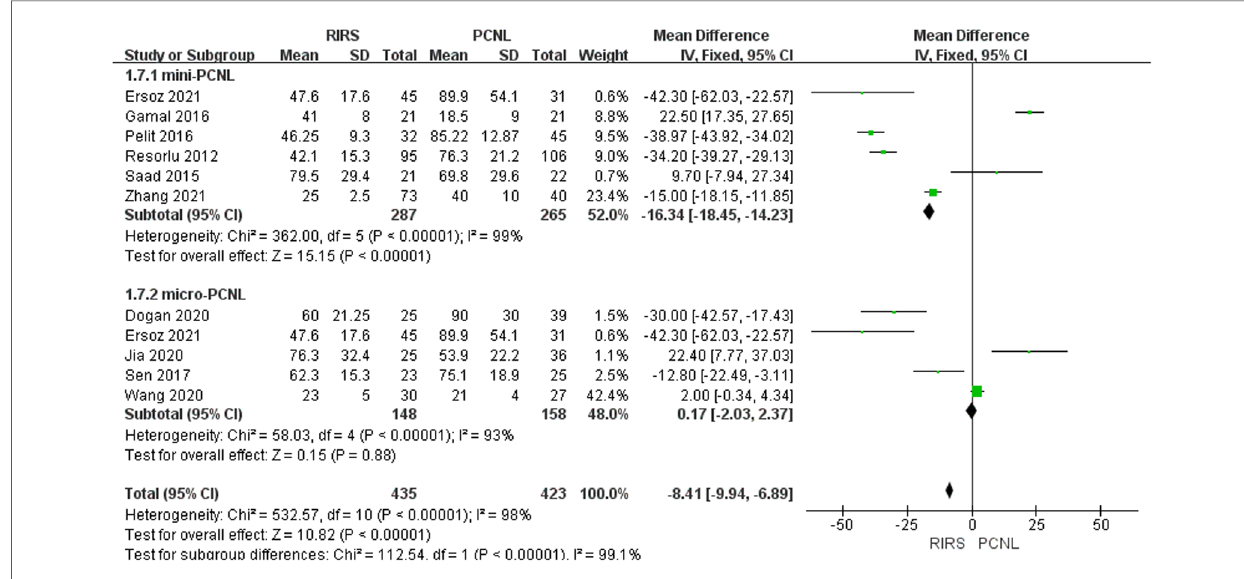
FIGURE 4 Forest plot of operation time between RIRS group and PCNL group.